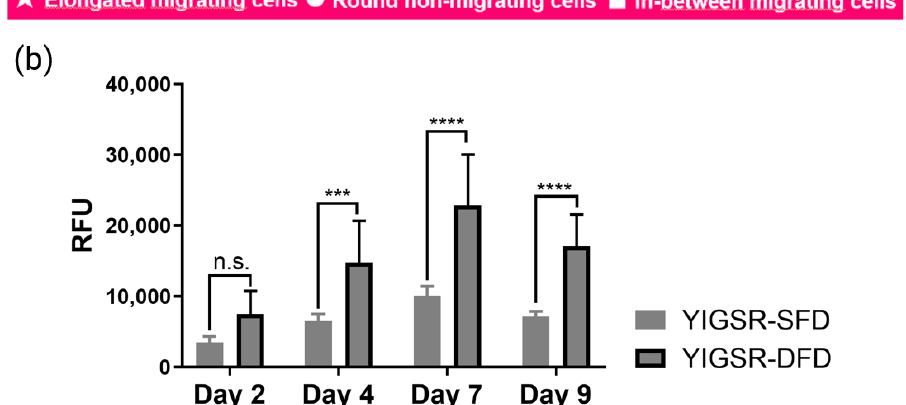
Figure 5. Cell analysis of seeded HUVECs on PUDNA-D20C scaffolds (SgC-SFD, top; SgC-DFD, bottom). ( a ) Images represent Z-Projection (average intensity) showing cell morphology at day 7 via CLSM. Scale bar = 100 µ m; ( b ) Cell metabolic activity determined by resazurin assay on days 2, 5, 7, and 9. Statistical analysis was performed using a two-way ANOVA. *** p < 0.001, **** p < 0.0001.